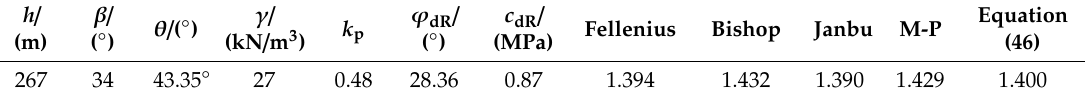
Figure 14. Calculation results of Slope/W software. Table 3. Comparison of slope safety factor calculated using different methods.